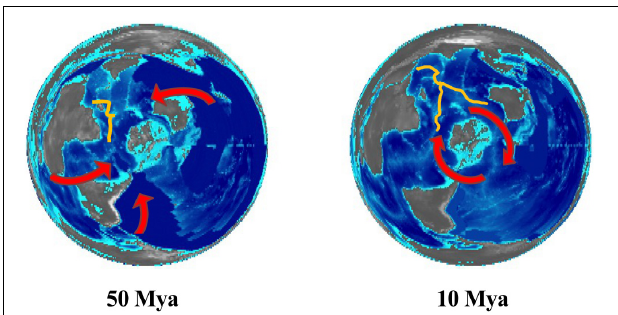
FIGURE 4 | Possible migration routes for vent species into the Indian Ocean. Paleo-digital elevation models from Scotese and Wright (2018) viewed from the South Pole. The Indian spreading ridges are sketched in